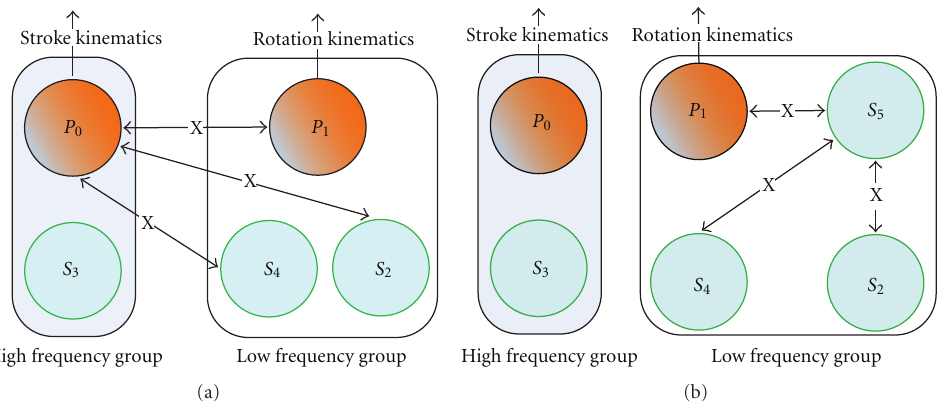
Figure 10: A pictorial representation of the “lesion study” process. The lesion study is based on the idea that it is possible to determine the underlying governing functional principle of the network with rigorously observing the behavior changes in the network for appropriate combinations of the amputations. Based on the complexity of the controller, the lesion study can be performed between neurons in distinct frequency groups, which is performing intergroup amputations, shown in (a), or between the neurons in the same frequency group, that is, intragroup amputations shown in